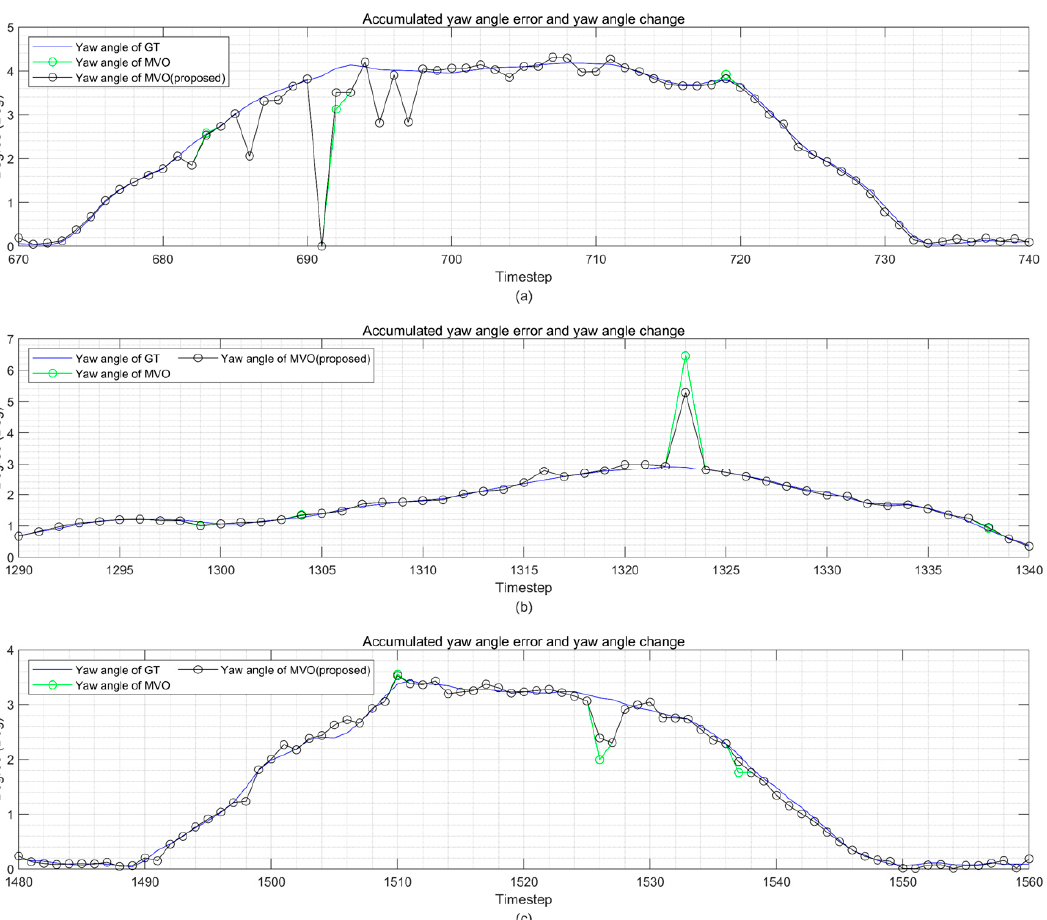
Figure 11. Enlarged cornering section of ground truth (GT), yaw angle obtained from the MVO, and yaw angle obtained from the MVO employing the proposed method when KITTI 06, 08, and 09 sequences are used. ( a ) KITTI sequence 06 over timesteps 670–740 is depicted. ( b ) KITTI sequence 08 over timesteps 1290–1340 is depicted. ( c ) KITTI sequence 09 over timesteps 1480–1560 is depicted.